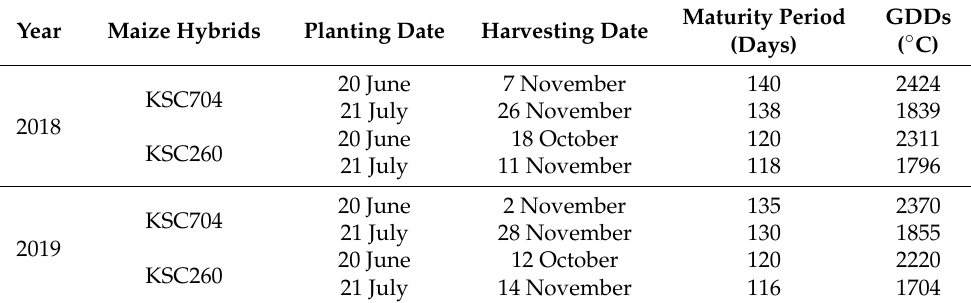
Table 2. Planting dates, harvesting dates, maturity period and growing degree days (GDDs) of cultivars in 2018 and 2019.